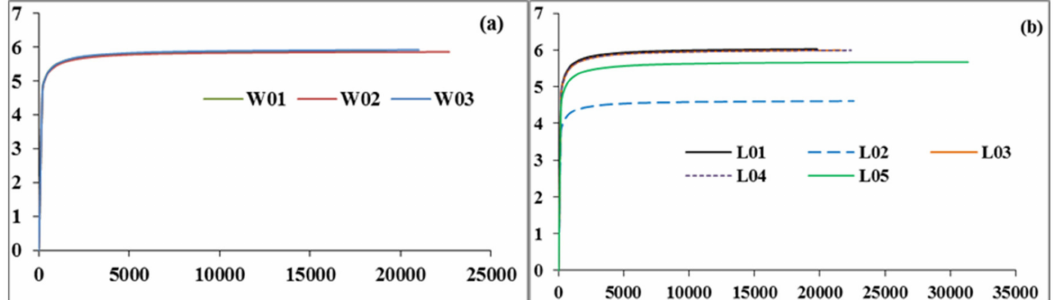
Figure 5. Rarefaction curve of the soil bacterial community (( a ) is the soil bacterial rarefaction curve at di ff erent depths, and ( b ) is the rarefaction curve at 15 cm under di ff erent vegetation